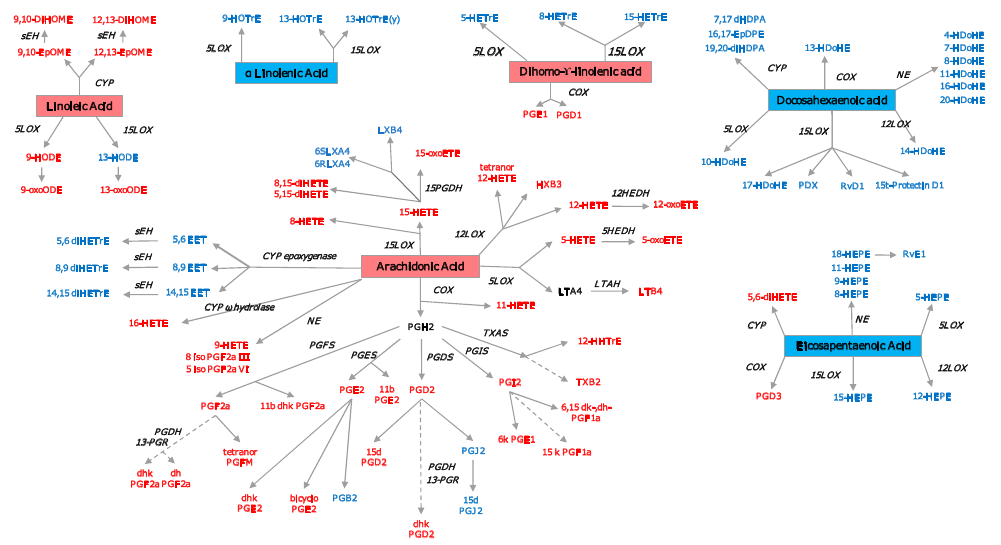
Figure 5. Oxylipin derived from PUFA. Pro-inflammatory oxylipins are marked in red, while anti-inflammatory ones are marked in blue. The precursor n3-PUFAs are marked in a red square, while the n6-PUFAs are marked in a blue square. COX – cyclooxygenase; LOX – lypooxigenase; CYP –